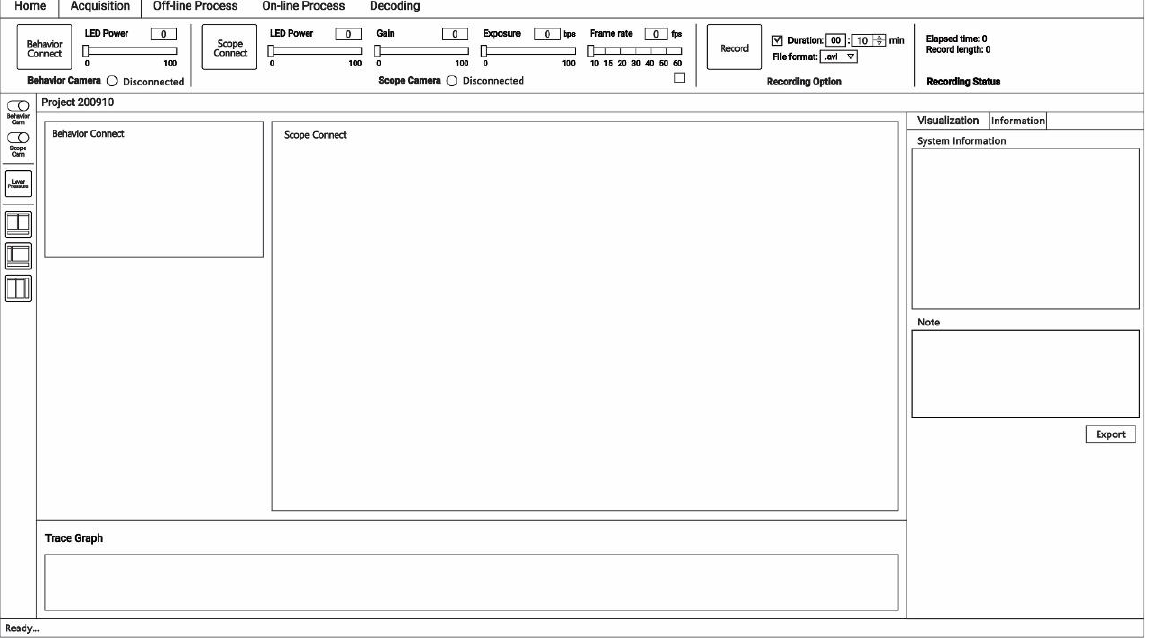
Figure 3. A wireframe design of data acquisition module for a new O-BMI system (illustrated).